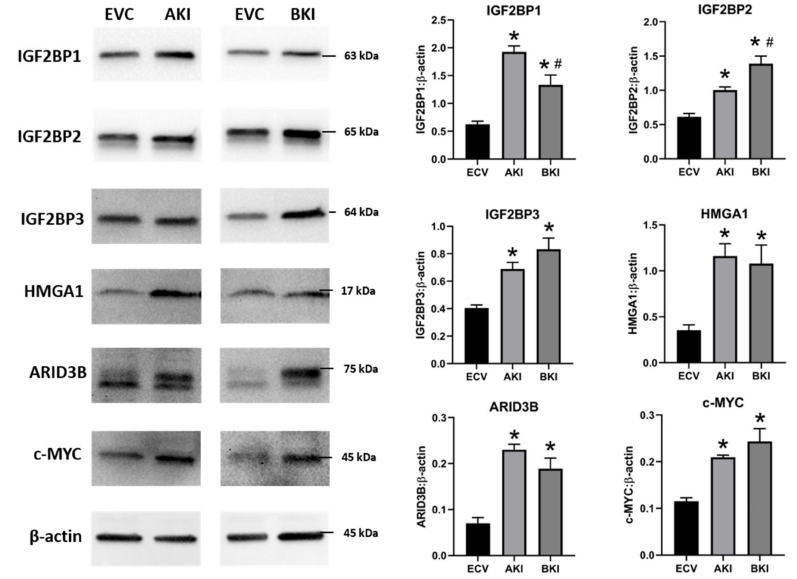
Figure 10. Representative immunoblots for IGF2BP1, IGF2BP2, IGF2BP3, HMGA1, ARID3B, c-MYC, and β -actin, and densitometric analysis of immunoblotting results in AKI and BKI iOTR cells compared to EVC ( n = 3), where * p < 0.05 vs. EVC and # p < 0.05 vs